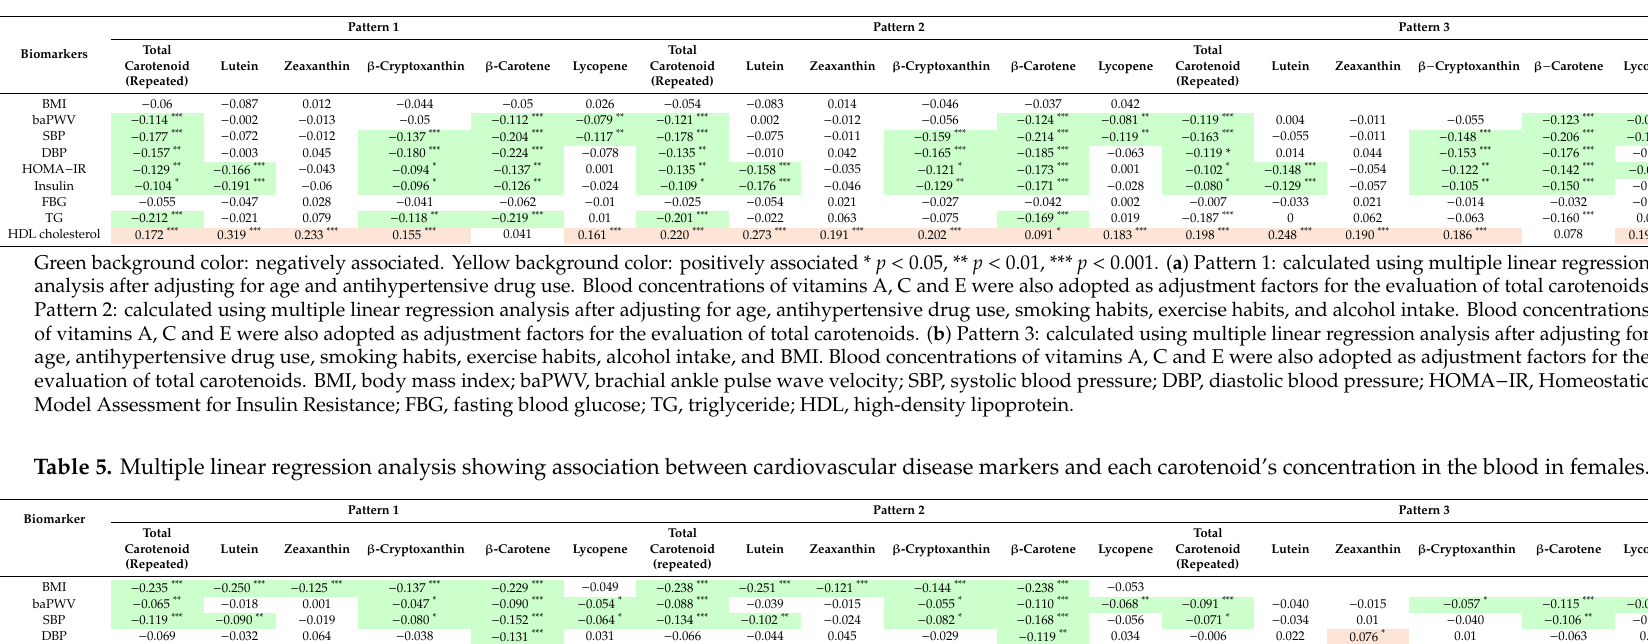
Green background color: negatively associated. Yellow background color: positively associated. * p < 0.05, ** p < 0.01, *** p < 0.001. ( a ) Pattern 1: calculated using multiple linear regression analysis after adjusting for age and antihypertensive drug use. Blood concentrations of vitamins A, C and E were also adopted as adjustment factors for the evaluation of total carotenoids; Pattern 2: calculated using multiple linear regression analysis after adjusting for age, antihypertensive drug use, smoking habits, exercise habits, and alcohol intake. Blood concentrations of vitamins A, C and E were also adopted as adjustment factors for the evaluation of total carotenoids. ( b ) Pattern 3: calculated using multiple linear regression analysis after adjusting for age, antihypertensive drug use, smoking habits, exercise habits, alcohol intake, and BMI. Blood concentrations of vitamins A, C and E were also adopted as adjustment factors for the evaluation of total carotenoids. BMI, body mass index; baPWV, brachial ankle pulse wave velocity; SBP, systolic blood pressure; DBP, diastolic blood pressure; HOMA-IR, Homeostatic Model Assessment for Insulin Resistance; FBG, fasting blood glucose; TG, triglyceride; HDL, high-density